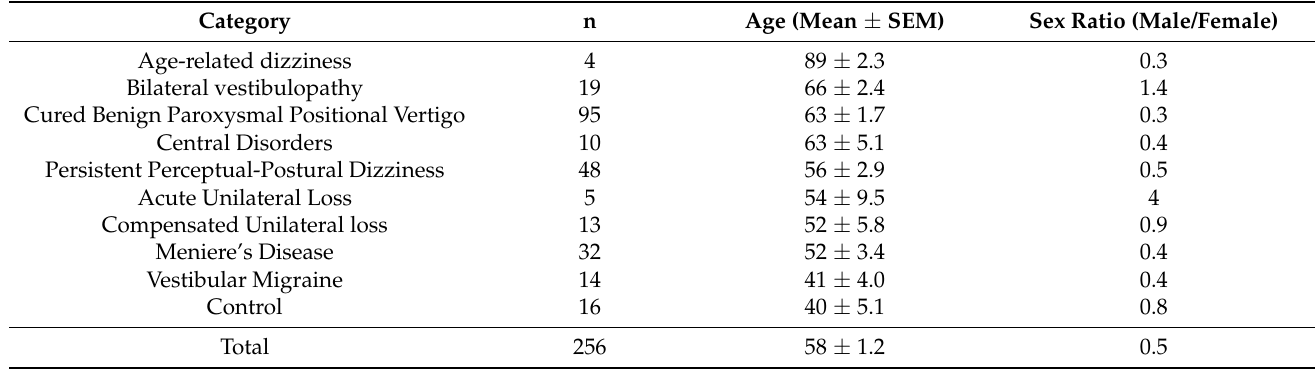
Table 1. Population characteristics. SEM: standard error of